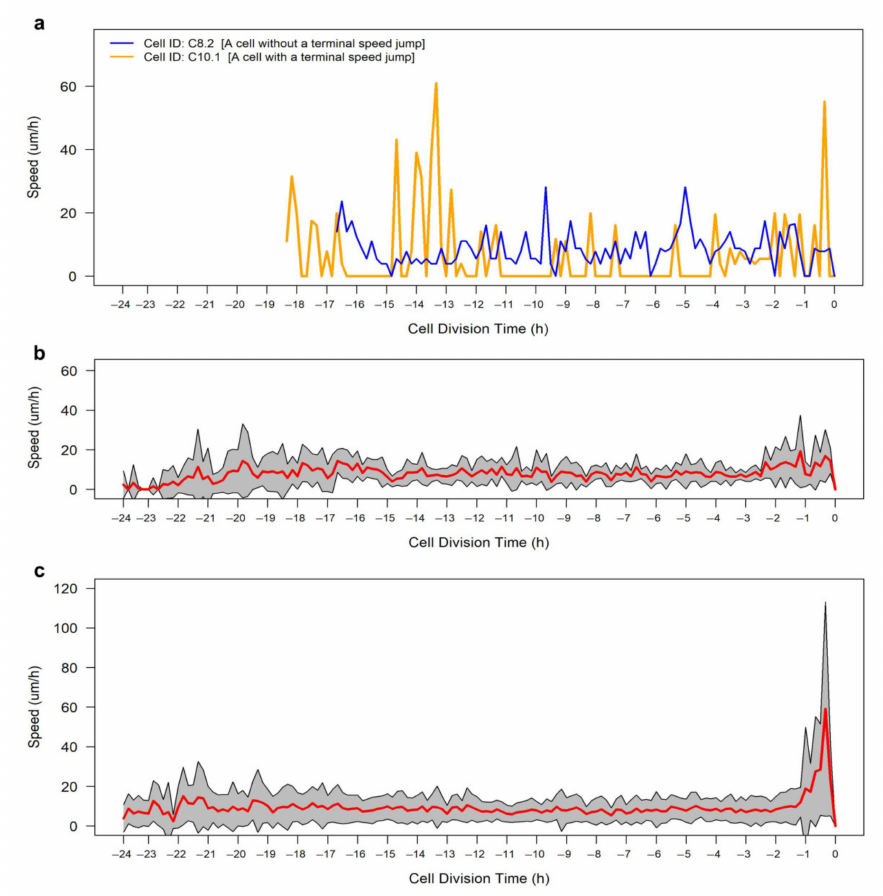
Figure 7. Speed profile of RPE cells across cell-cycle phases. ( a ) Examples of RPE cells without (C8.2) and with (C10.1) a terminal speed jump. ( b ) Speed profile of cells ( n = 13) without a terminal speed jump. ( c ) Speed profile of cells ( n = 35) with a terminal speed jump. Red lines show the average instantaneous speeds, whereas the gray shaded areas show the standard